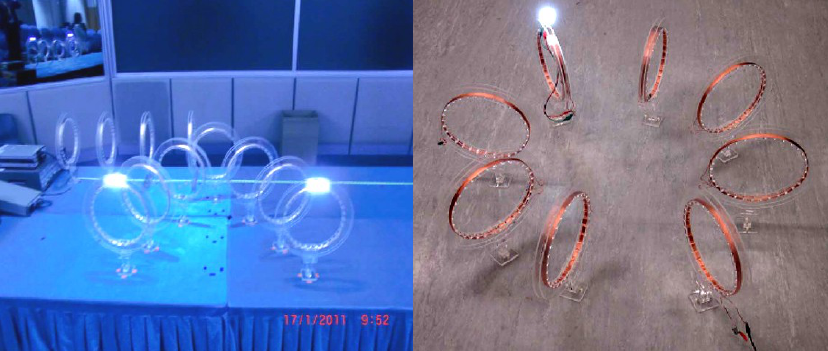
Figure 4. System architecture with multi-relay coils. The left one shows the system architecture with multi-relay coils which is arranged non-coaxially. The right one shows the system architecture with multi-relay coils which is arranged circularly.